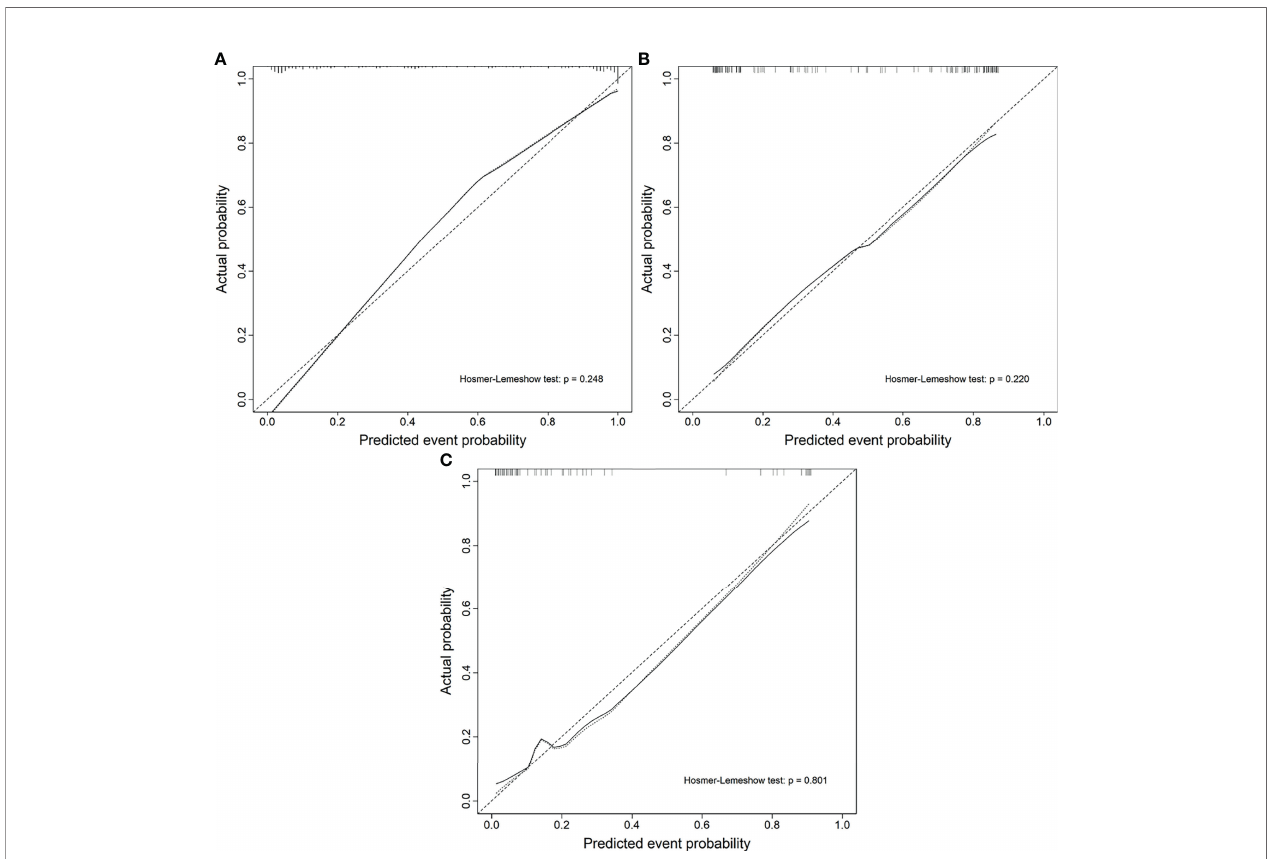
FIGURE 5 | Calibration curves of the radiomics nomogram. (A) The training group. (B) The test group. (C) The external validation group.